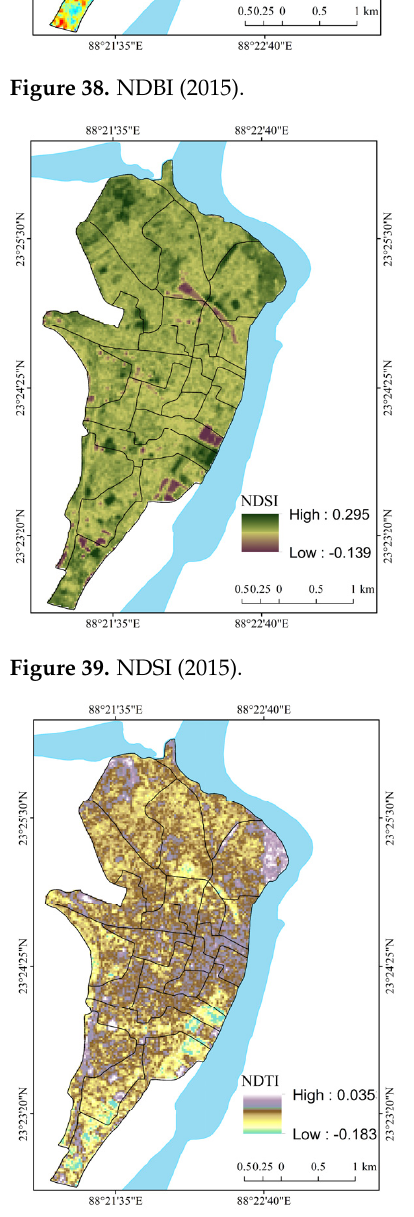
Figure 40. NDTI Figure 40. NDTI (2015).